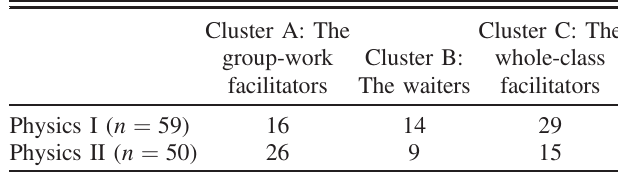
TABLE X. Distributions of class periods observed in different clusters in each course.